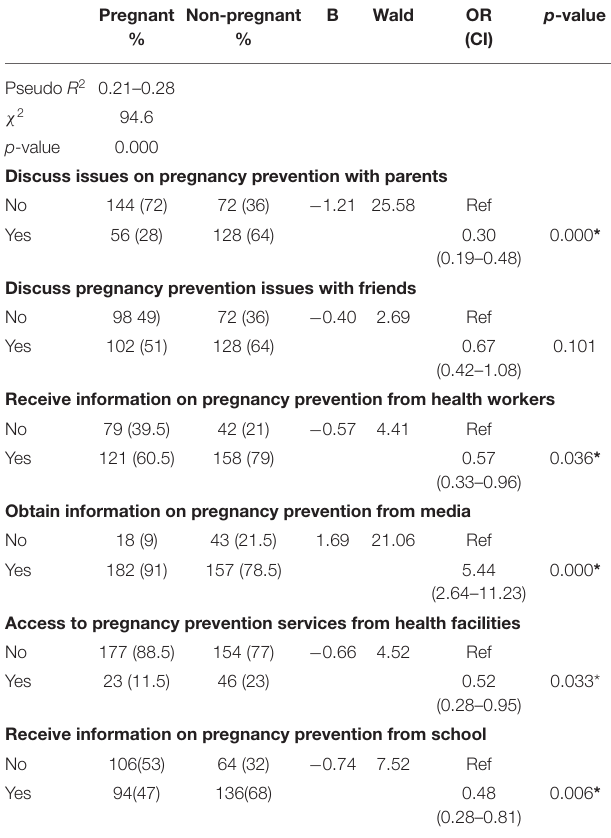
TABLE 3 | Influence of access to pregnancy prevention information and services on adolescent